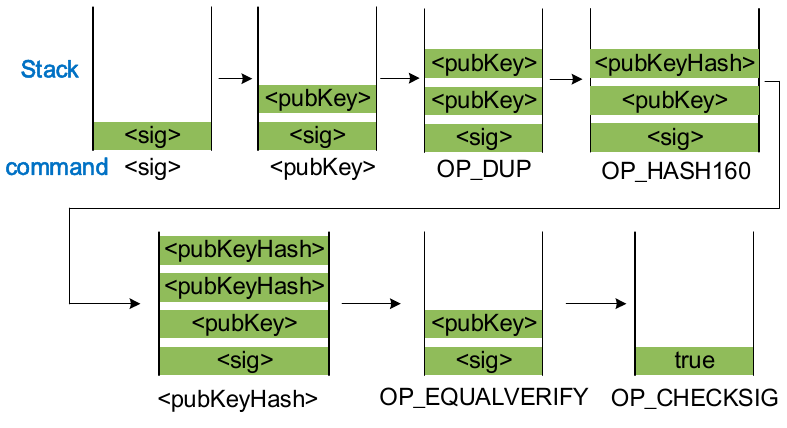
Figure 2. Script execution process.